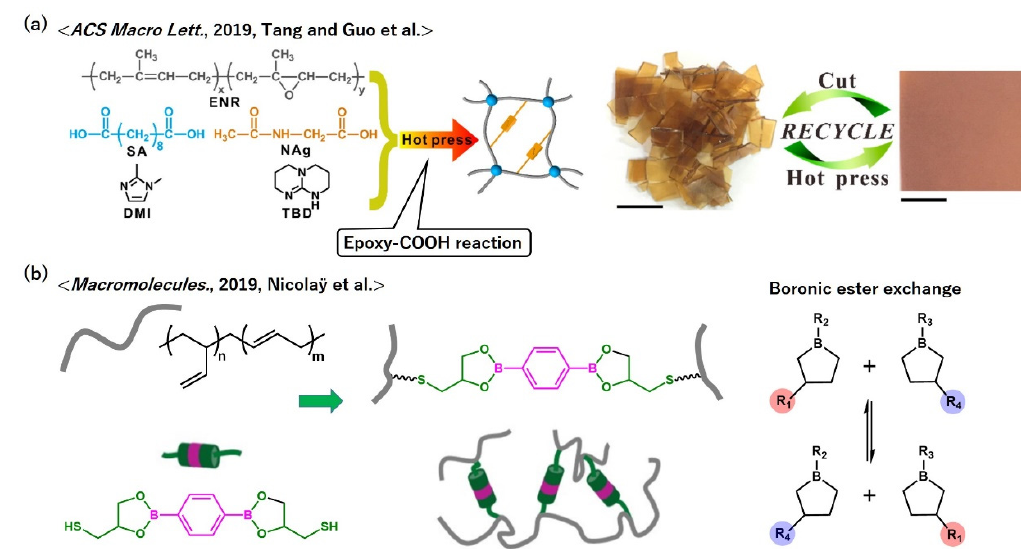
Figure 13. Molecular designs of vitrimer polydienes according to ( a ) ref. [59] and ( b ) ref. [60]. In ( a ), the visual representation of recyclability is also provided. In ( b ), the bond exchange mechanism of the boronic ester exchange is shown. ( a ) Adapted with permission from ref. [59]. Copyright (2019) American Chemical Society. ( b ) Adapted with permission from ref. [60]. Copyright (2019) American Chemical Society.